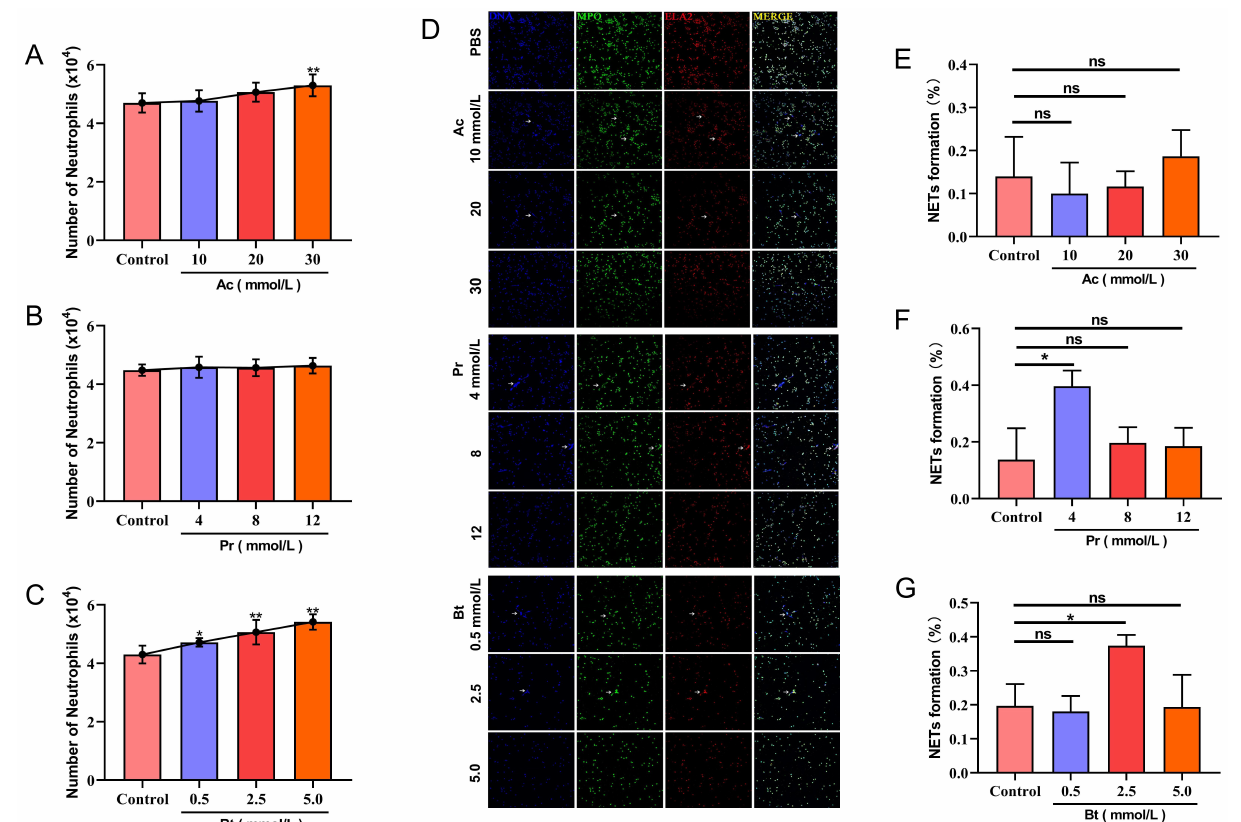
Figure 3. Effects of Ac, Pr, and Bt on migration and NET formation of PMN. ( A ) Effects of Ac on migration of PMN; ( B ) effects of Pr on migration of PMN; ( C ) effects of Bt on migration of PMN; ( D ) effects of Ac, Pr, and Bt on NET formation of PMN (white arrows: NET); ( E ) effects of Ac on the percentage of NET formation; ( F ) effects of Pr on the percentage of NET formation; ( G ) effects of Bt on the percentage of NET formation. Data are shown with means ± SD ( n = 3). * p < 0.05, ** p < 0.01, compared to control